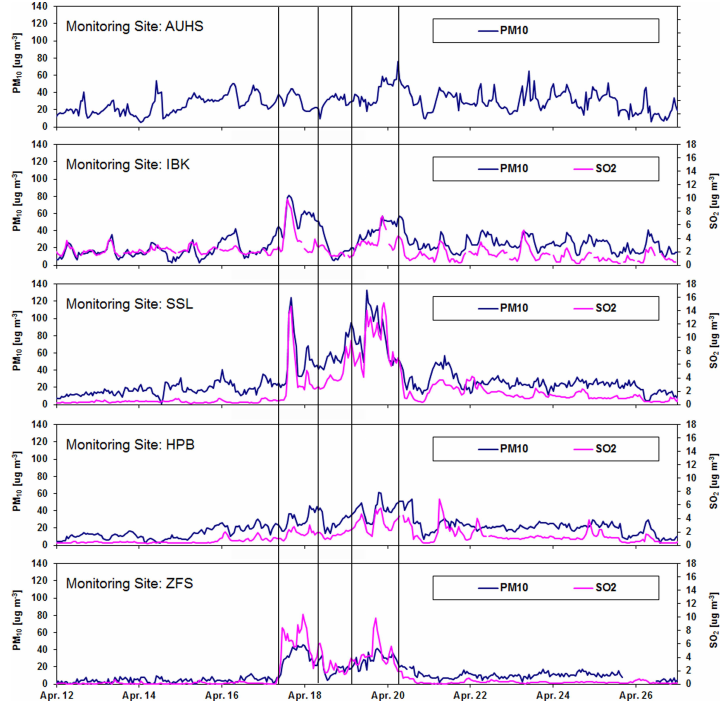
Fig. 6. Time series of PM 10 and SO 2 (hourly mean data) concentrations at the five core measurement sites Augsburg (AUHS), Innsbruck (IBK), Schauinsland (SSL), Hohenpeissenberg (HPB) and Zugspitze/Schneefernerhaus (ZSF) in the time period from 12 April to 27 April. The two main entrainment events of the volcanic plume are shaded. Note that PM 10 and SO 2 show a strongly correlated evolution at all measurement